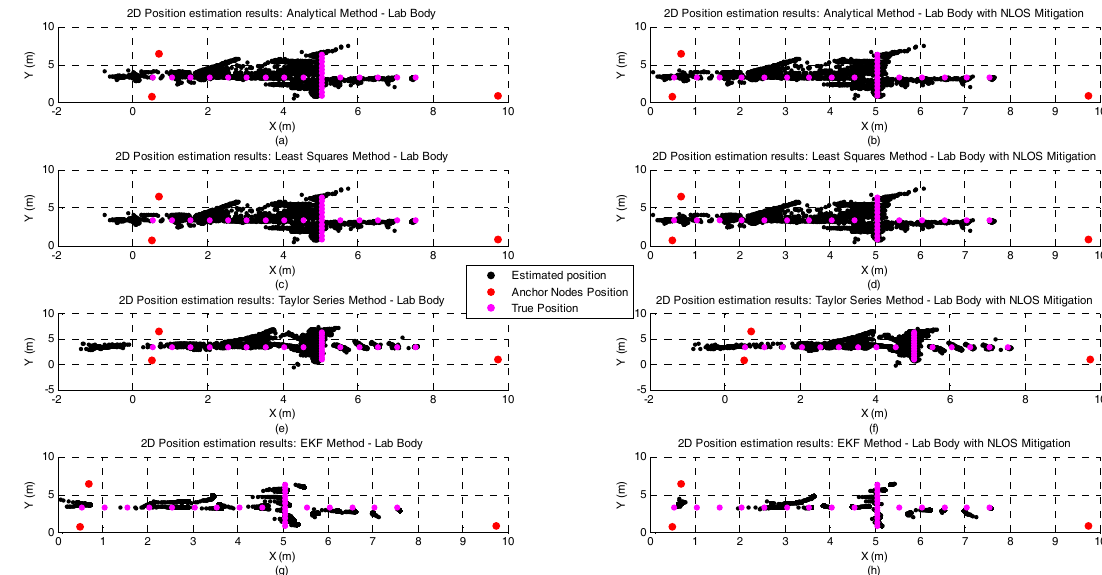
Figure 9. Graphical illustration of the 200 position estimates for each test point in the lab scenario, with human body interference, and with or without NLOS mitigation. The plots on the left side of the figure represent the position estimates without NLOS mitigation and the plots on the right the position estimates with NLOS mitigation. Each row represents the results obtained by each positioning algorithm and their order from the top to the bottom of the figure is: Analytical method —( a , b ); Least Squares method—( c , d ); Taylor Series method—( e , f ); and EKF Method—( g , h ).